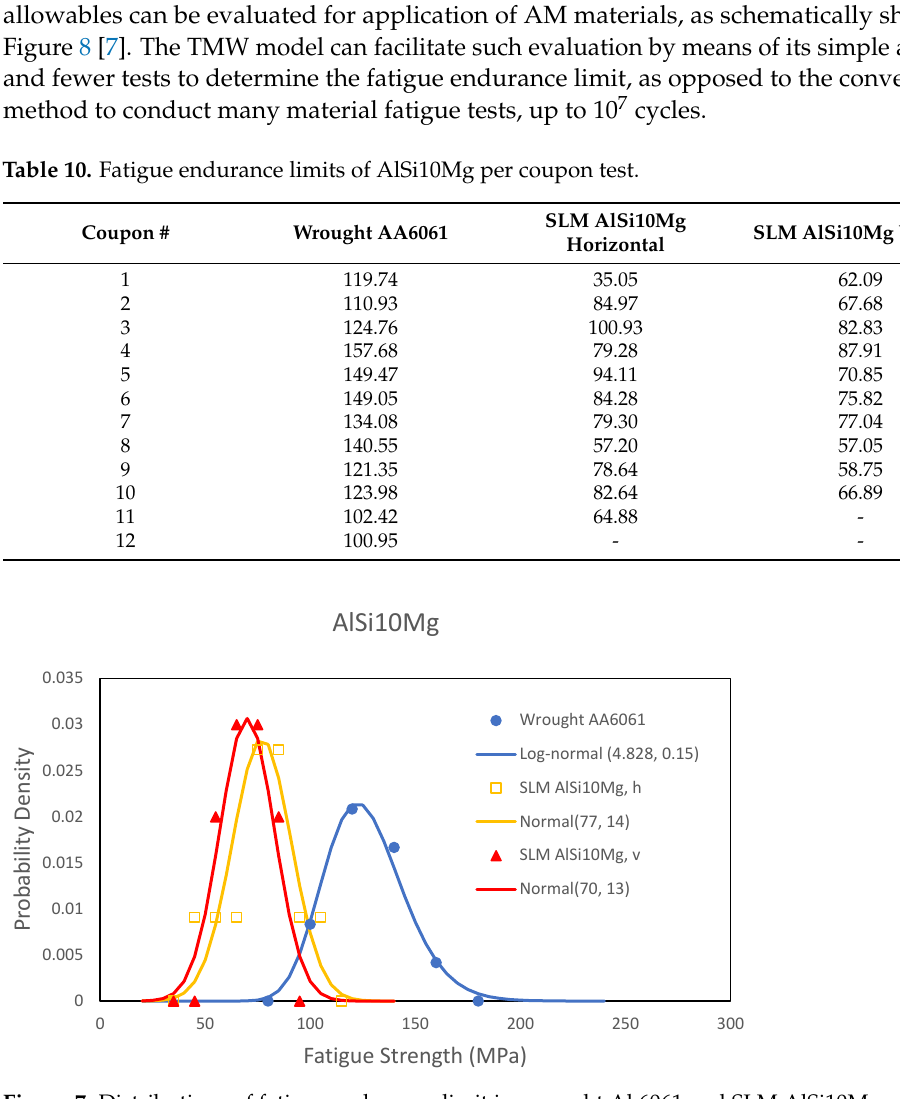
Table 10. Fatigue endurance limits of AlSi10Mg per coupon test.